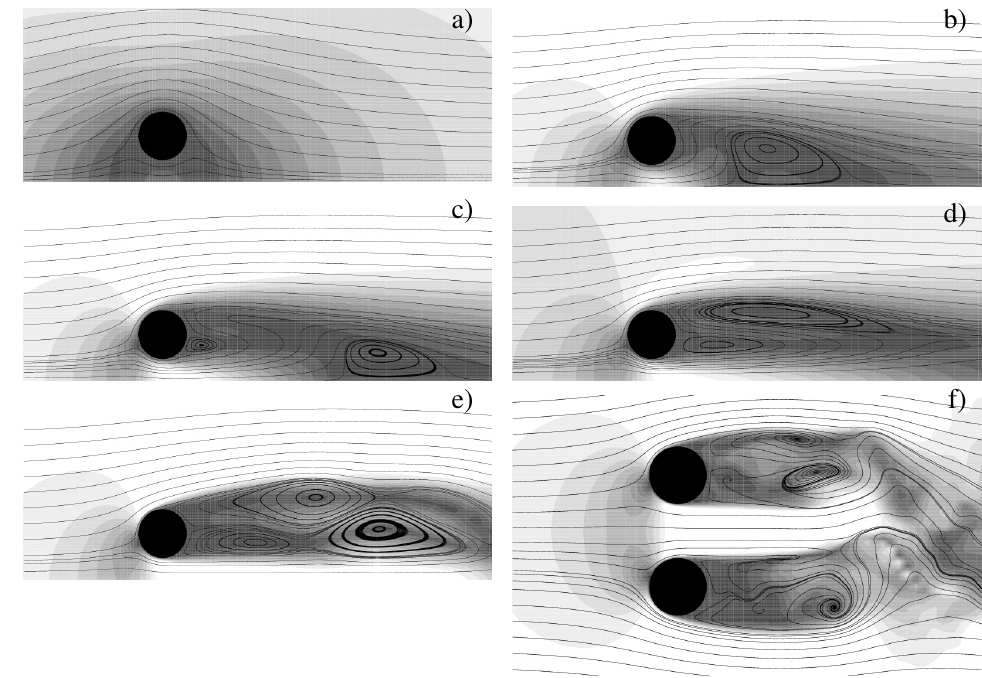
Figure 4. Instantaneous snapshots of streamwise velocity (gray scales) and streamtraces ( ) for the flow around a torus at Γ = 1: ( a ) Re = 0.1; ( b ) Re = 25; ( c ) Re = 50; ( d ) Re = 100; ( e ) Re = 275; ( f ) Re = 500.